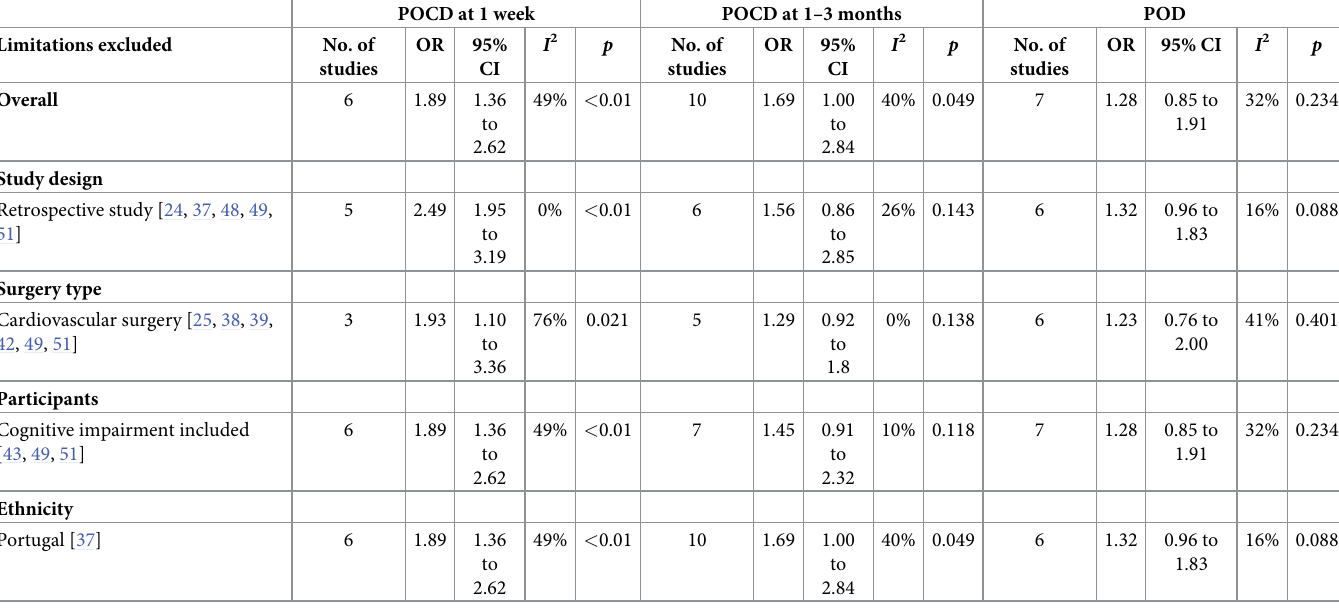
Table 3. Sensitivity analyses: Effect of different research characteristics on POCD or POD with ApoE4 carriers.